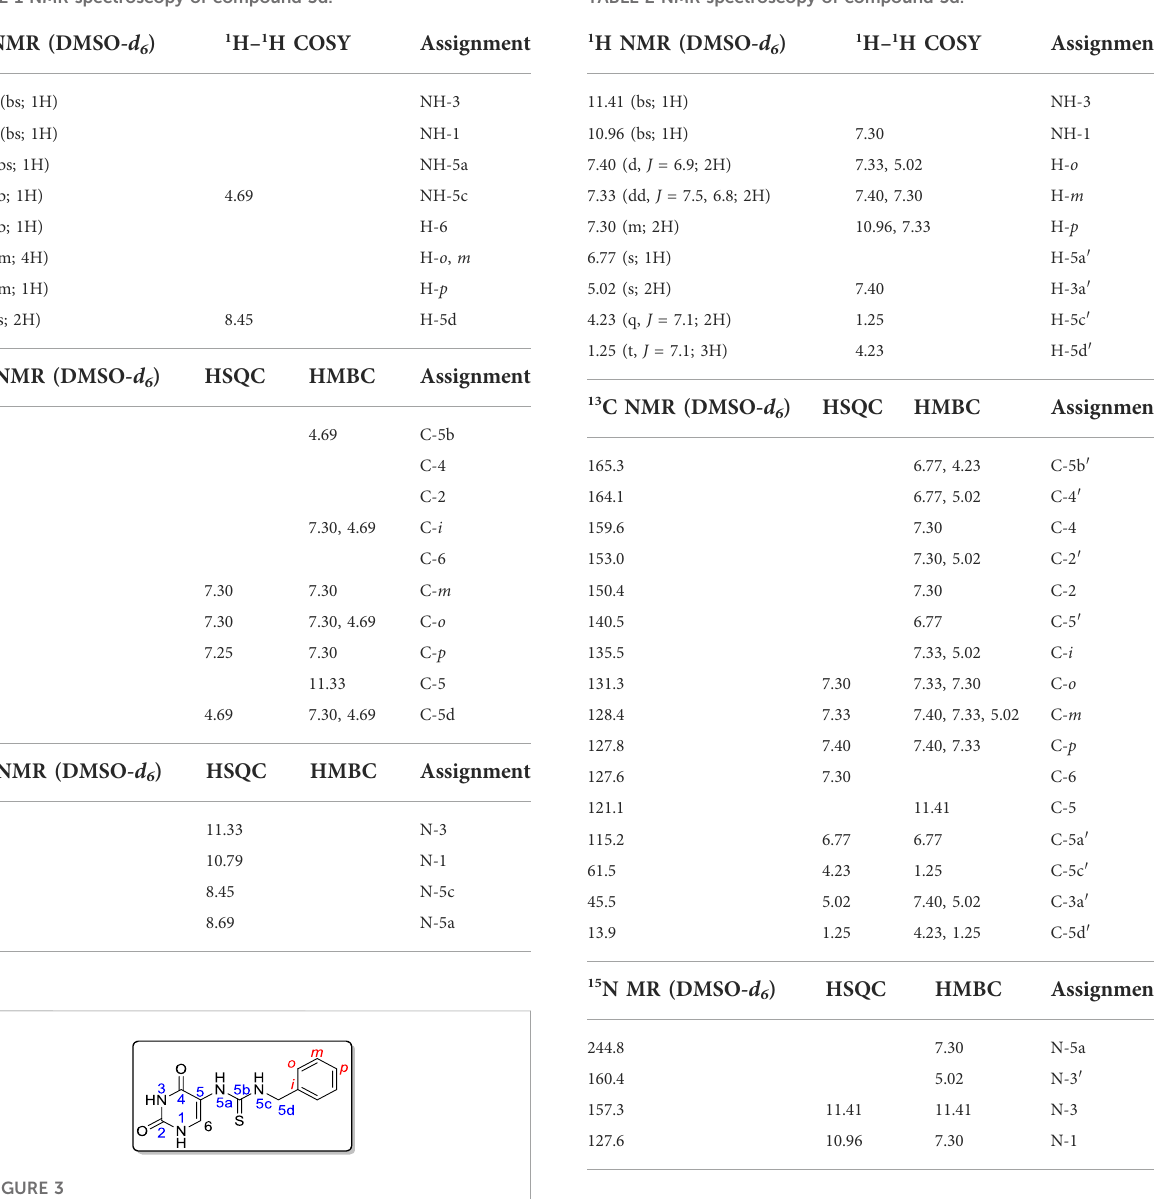
TABLE 1 NMR spectroscopy of compound 3d.